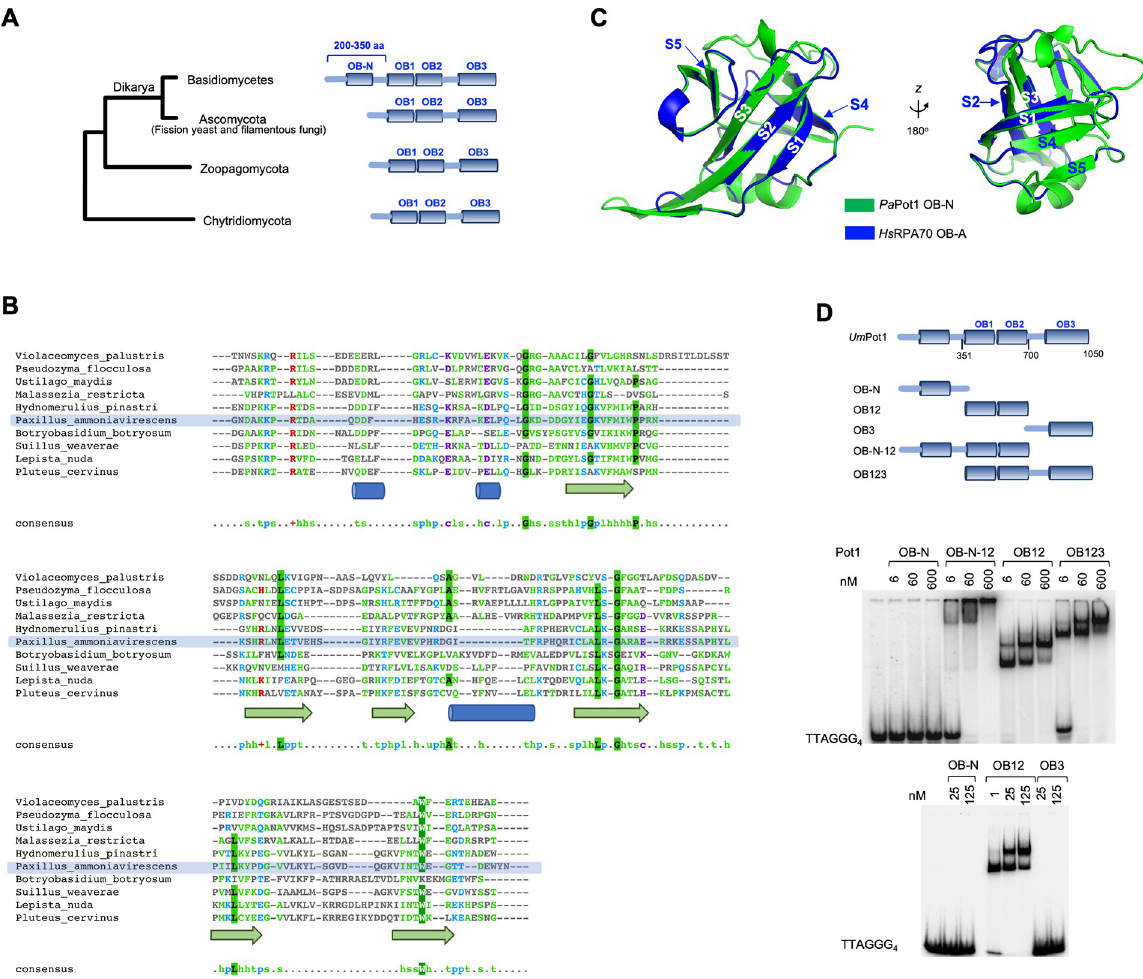
Fig 1. U maydis Pot1 and other basidiomycetes harbor an extra N-terminal OB fold domain. A. Domain organization of Pot1 homologs from major fungal branches. B. Multiple sequence alignment of the N-terminal region of Basidiomycete Pot1 homologs. The alignment and secondary structure predictions were generated using PROMALS3D and displayed using MView. C. A homology model of the putative OB-N domain from Paxillus ammoniavirescens ( Pa Pot1) (generated from SWISS-MODEL) is superimposed on the OB-A domain of human RPA70. Note that the five beta strands (labeled as S1 to S5) in the two structures are spatially well aligned. D. EMSA analysis of the DNA-binding activities of Um Pot1 truncation variants. The domains included in each variant are illustrated at the top and the binding assays shown at the bottom. 5’-labeled G4 oligonucleotide was used as the